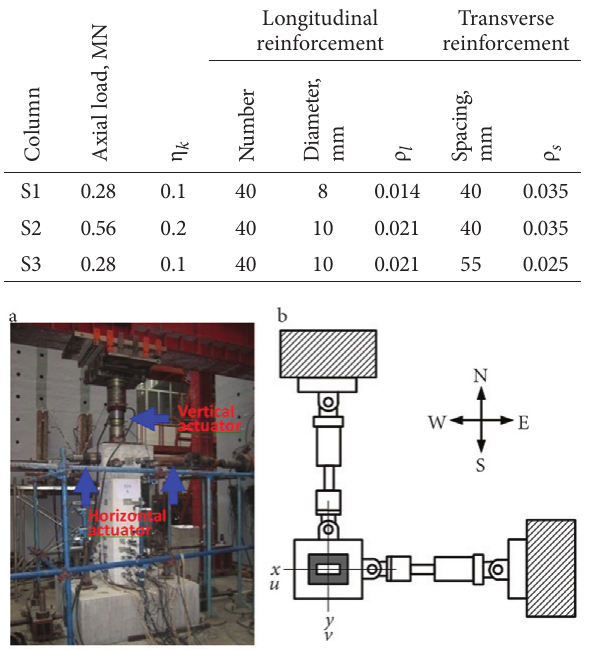
Fig. 7. Bilateral loading setup and protocol: a – test setup; b – Bi-directional loading